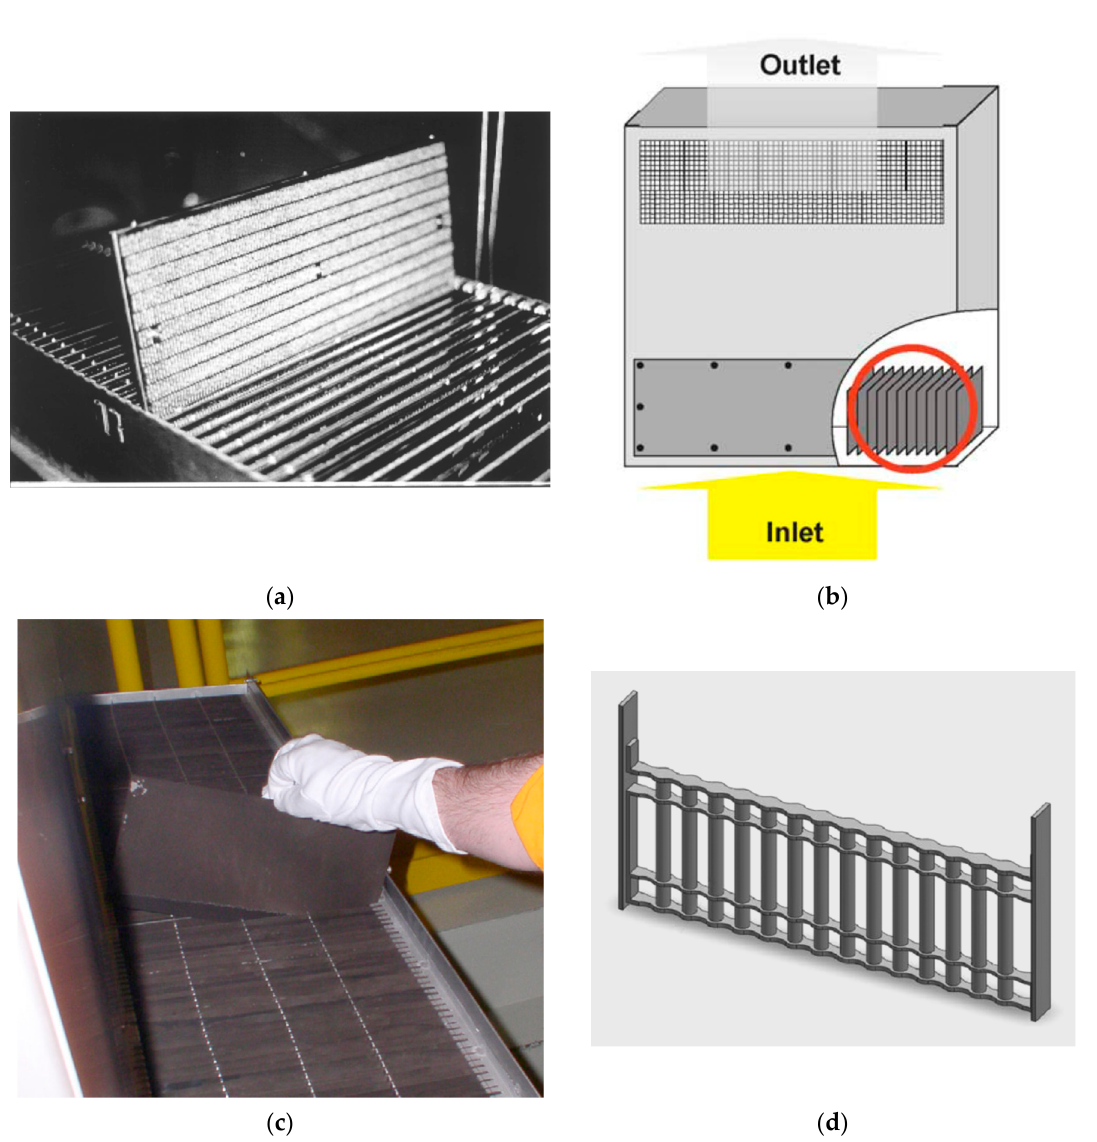
Figure 19. ( a ) Cartridge-type catalyst section in a PAR (reproduced from [183] with permission from Elsevier); ( b ) schematic of the plate-type catalyst section (reproduced from [184] with permission from Elsevier); ( c ) photograph of the plate-type catalyst section (reproduced from [185] with permission from Elsevier); ( d ) rod-shaped catalyst section in the PAR developed by ISPC RET (reproduced from [186] with permission from Springer Nature).